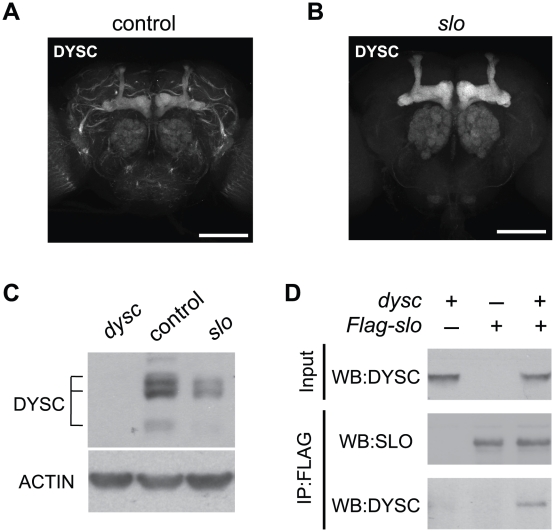
SLO and DYSC form a mutually dependent complex.(A–B) Maximal intensity confocal projections showing DYSC expression in wild-type control (A) and slo
4 (B) adult brains. Relative to control flies, DYSC expression in neuronal tracts is severely reduced in slo
4 mutants. In contrast, DYSC expression in the mushroom body lobes, antennal lobes and ellipsoid body remains intact in slo
4 mutants. Scale bar represents 100 µm. (C) Loss of SLO reduces DYSC expression in head extracts. Both long and short isoforms of DYSC show a clear reduction in slo
4 mutants. Actin was used as a loading control. (D) DYSC physically interacts with SLO in HEK-tsA cells. Cultured cells were transfected with constructs encoding DYSC and FLAG-tagged SLO, or either construct alone. Cell extracts were immuno-precipitated (IP) using an anti-FLAG antibody, and subjected to western blotting (WB) using an anti-DYSC or anti-SLO antibody.